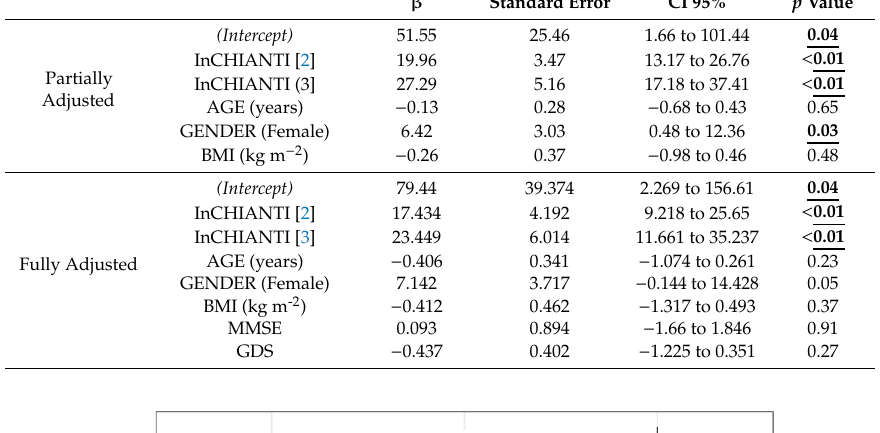
Table 4. Linear regression model on activity energy expenditure (AEE; kJ day − 1 kg − 1 ) as dependent variables and regressors.